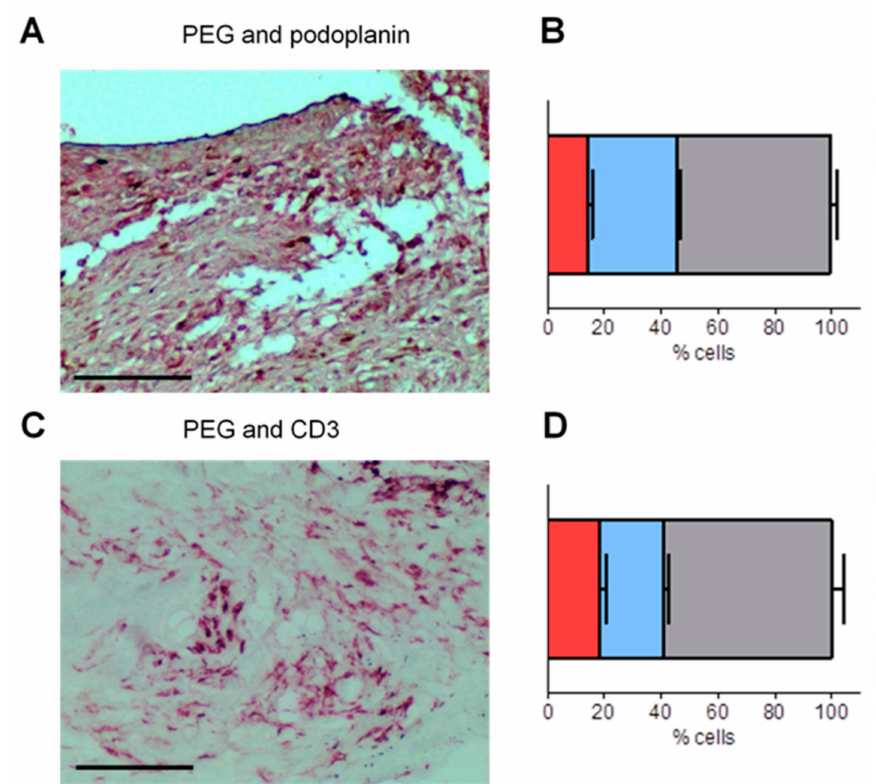
Figure 4. PEG-HCCs colocalize with podoplanin- and CD3-expressing cells. ( A ) Staining of PEG in blue / grey and of podoplanin in red in the synovium of a PIA rat treated with PEG-HCCs. Scale bar = 100 µ m. ( B ) Quantification of cells expressing only podoplanin in red, of cells expressing only PEG in blue, and of cells expressing both markers in grey. ( C ) Staining of PEG in blue / grey and of CD3 in red in the synovium of a PIA rat treated with PEG-HCCs. Scale bar = 100 µ m. ( D ) Quantification of cells expressing only CD3 in red, of cells expressing only PEG in blue, and of cells expressing both markers in grey. n =